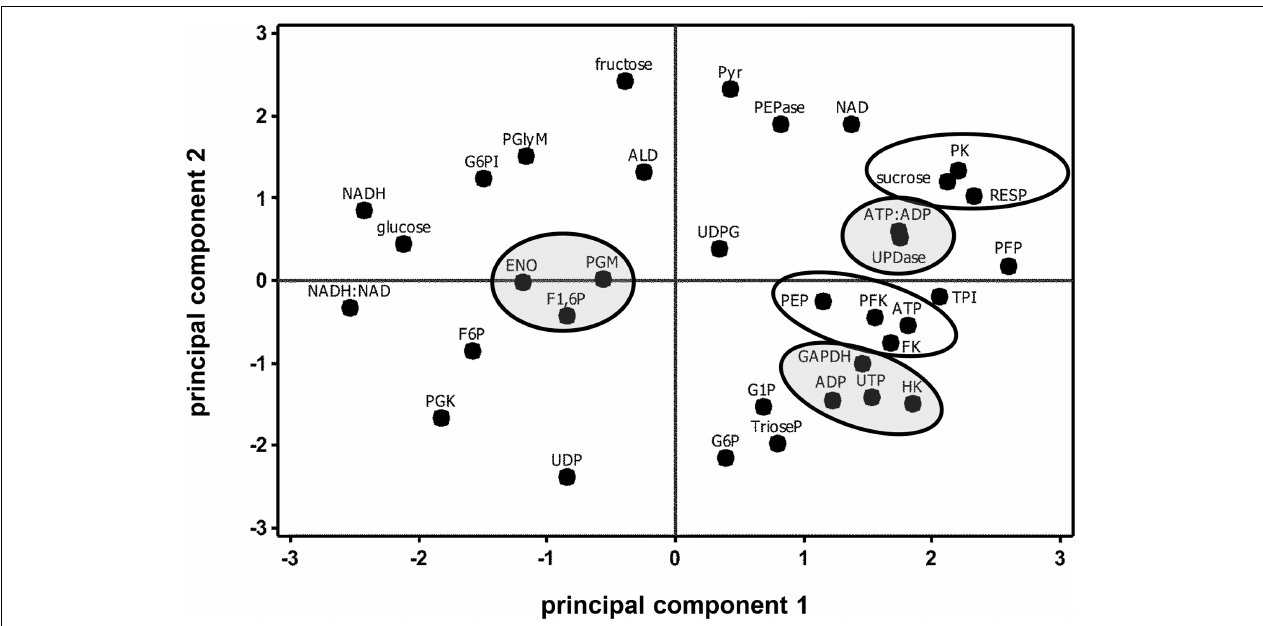
FIGURE 6 | Principal component analysis score plot of the changes in glycolytic enzyme activities, metabolite concentrations, ATP:ADP ratio, NADH:NAD + ratio, and respiration rate (RESP) during 60 days storage. Ovals identify parameters that exhibit similar storage-related changes. Ovals are gray where parameters share similar changes, but have no obvious connection with each other. Roots were stored 10 days at 10 ◦ C and 90 ± 5% RH, then stored at 4 ◦ C, 90 ± 5% RH for 50 days. Principal components 1 and 2 account for 34 and 26%, respectively, of the variance in the data after standardization. Abbreviations used for enzyme activities are defined in Table 1 ; abbreviations used for metabolites are defined in Table 3 . PCA loading plot is available in Supplementary Figure